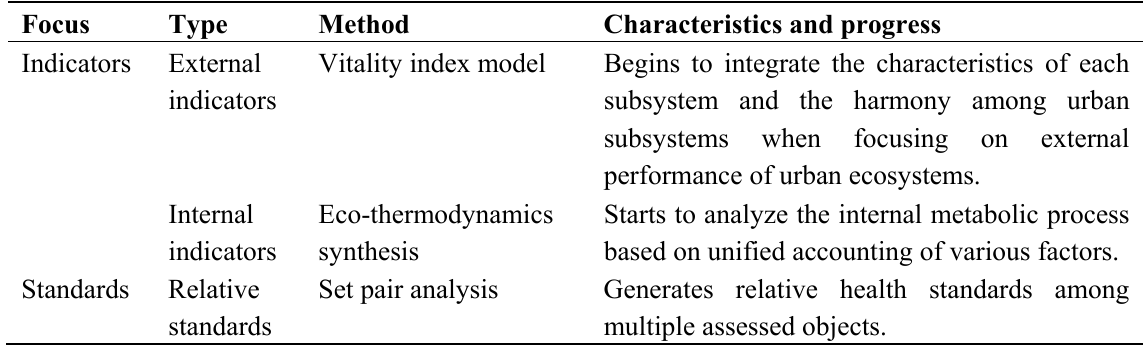
Table 1. Methods of urban ecosystem health